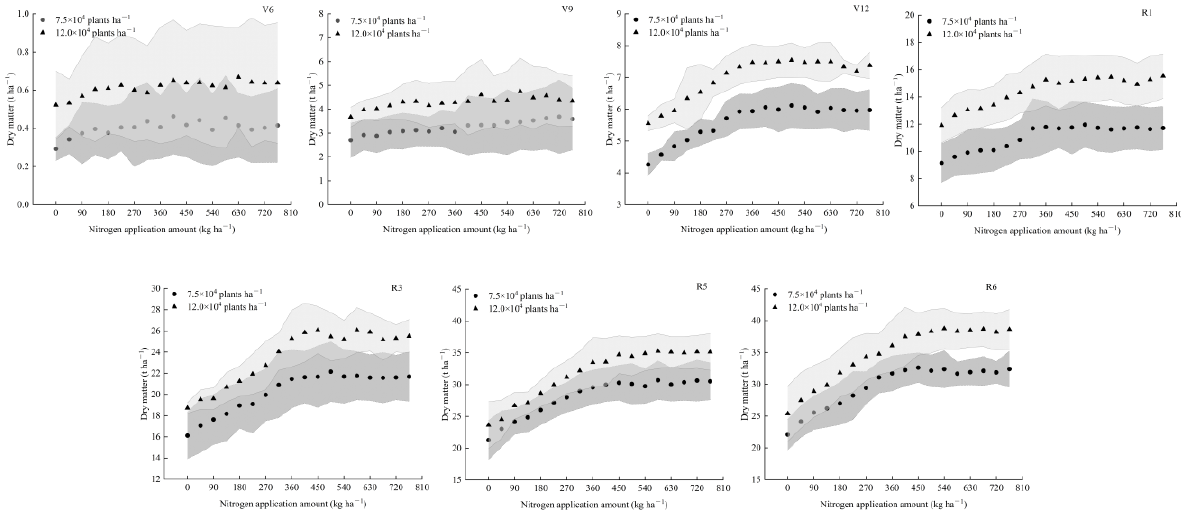
Figure 5. Effect of the nitrogen application rate on the dry matter accumulation in each period under different density conditions.